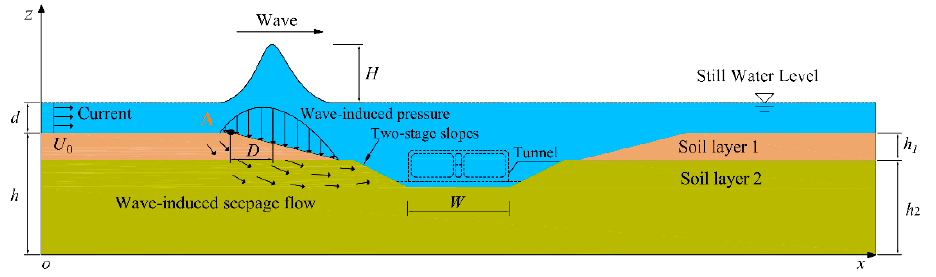
Figure 1. The solitary wave–artificial submarine slope coupling model.